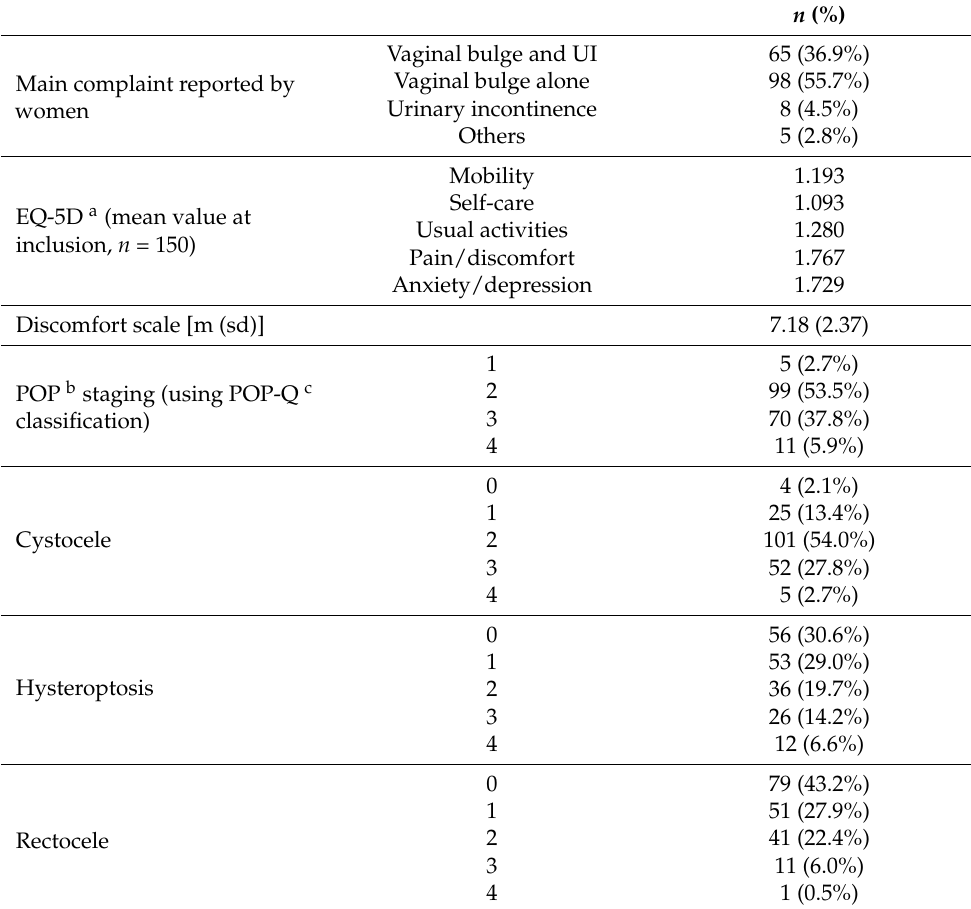
Table 2. Clinical evaluation and symptoms at inclusion.